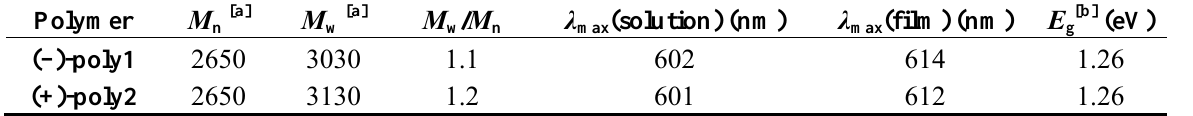
Table 1. Polymerization and optical absorption spectra